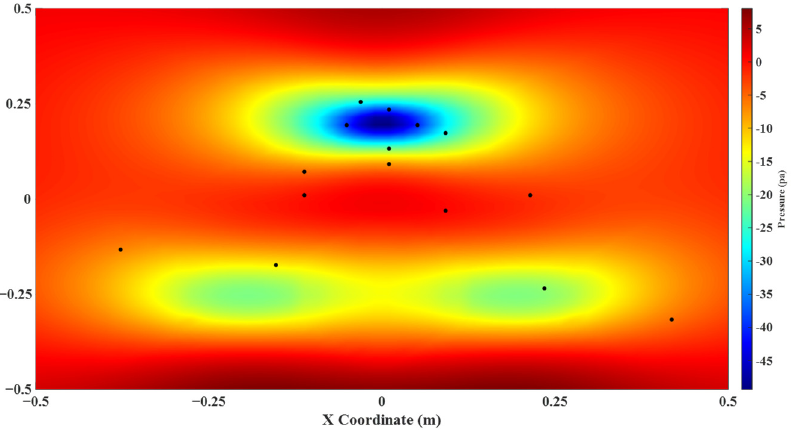
Figure 24. Reconstructed pressure nephogram (boundary condition 1) of the first plane with fifteen sensor positions (black points).